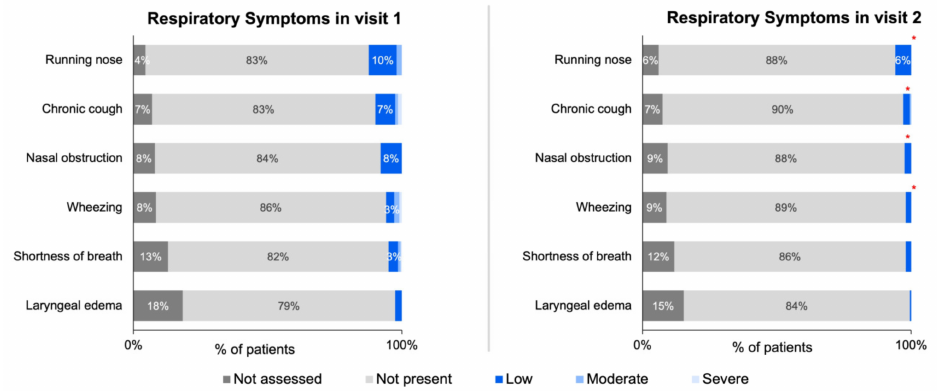
Figure 5. Distribution of respiratory symptoms severity across initial and follow-up visits for infants ≤ 6 months of age with suspected or diagnosed CMPA. Note: ‘*’ denotes statistically significant symptom improvement between Visit 1 and Visit 2 (specific p -values listed in Figure S3).